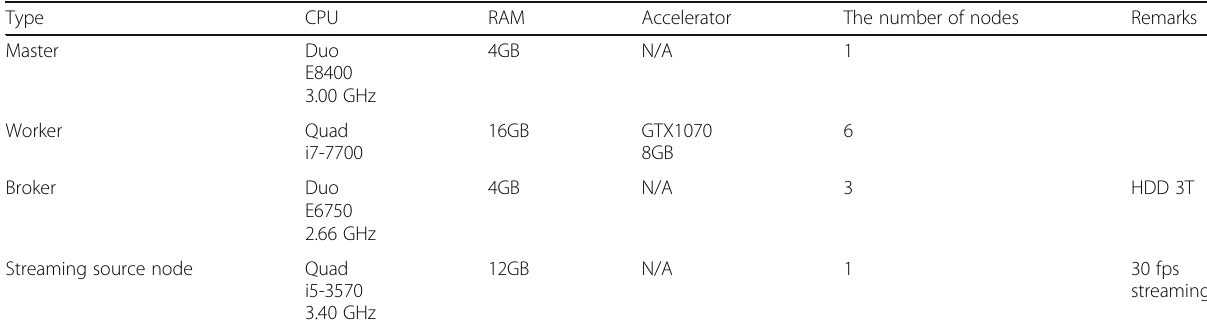
Table 1 System specifications for experiments